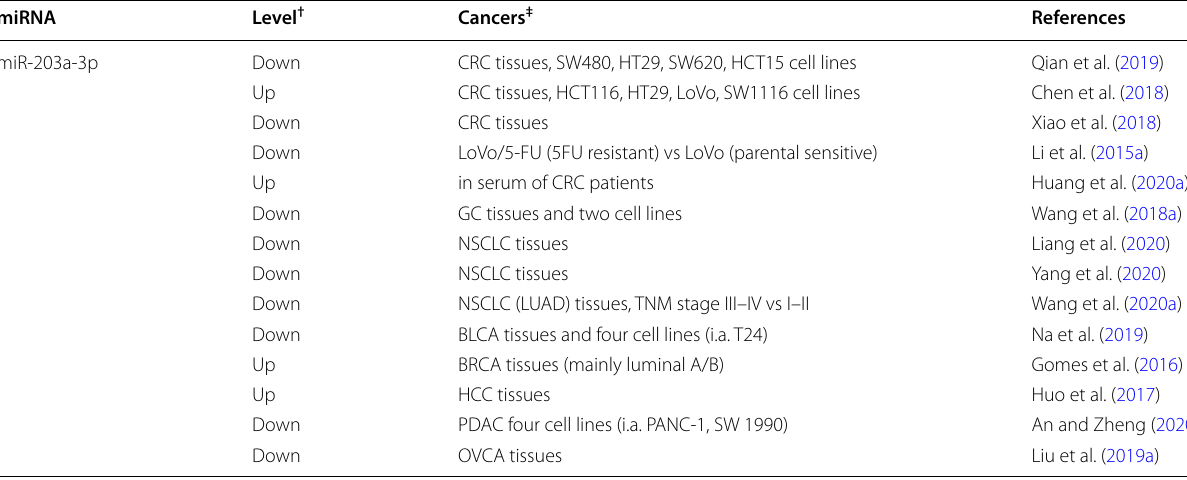
Table 8 Expression levels of miRNAs targeting i.a. T YMS mRNA in